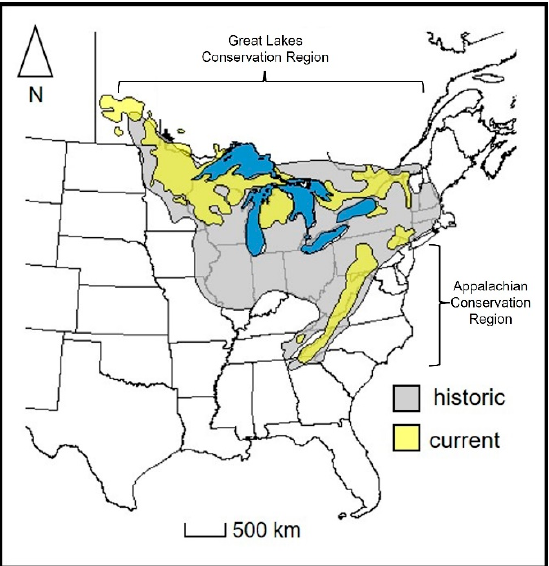
Figure 5. Historic and current estimated range of golden-winged warblers within eastern North America. The range has contracted by approximately 66% over the past 50 years.